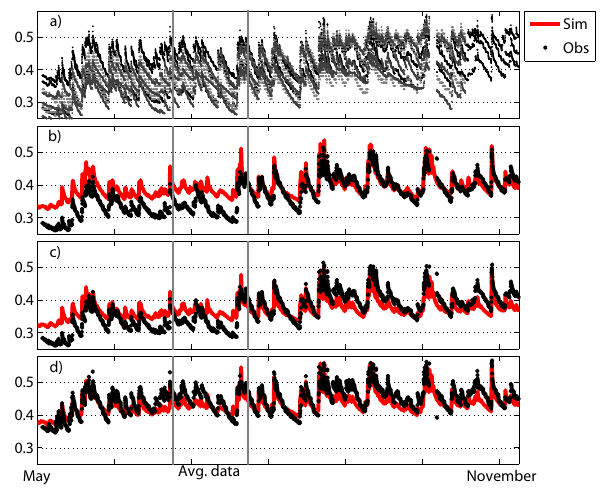
Fig. 3. Observed and modeled data for the period of May through November 2008. Panel (a) reports all the nine time series available; (b) , (c) and (d) show three of the observed series and the corre- sponding simulated ones. The three simulations used the clay loam soil-type parameters, and were obtained with the highest value of K sat (50mmh − 1 ) and different values of anisotropy ratio, equal to 100, 150 and 200, respectively. The vertical lines delimit the time period when hourly data were not available and were reconstructed from average values (see text for